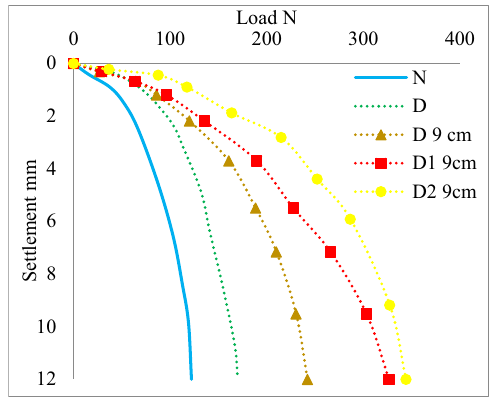
Figure 14: Load – settlement relation of footing resting on soil grouted outside the footing to a depth of 9